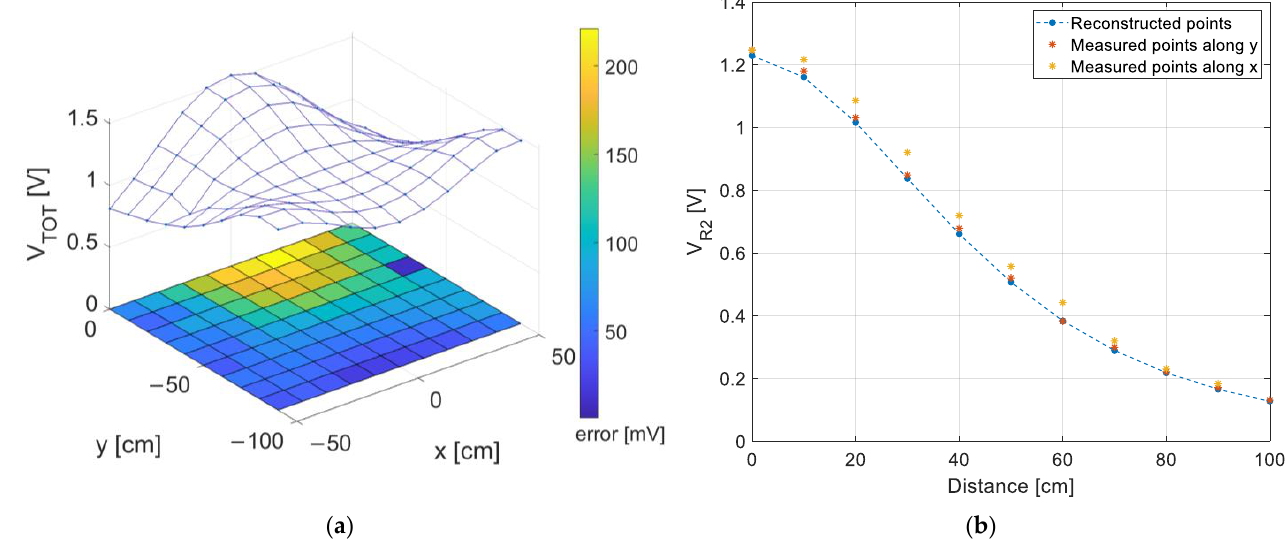
Figure 9. ( a ) The estimated RSSs distribution of the three LEDs as a 3D blue surface (i.e., the sum of the FFT-derived V Ri in each measurement point, V TOT ), on the ( x , y ) plane a heatmap reporting the absolute difference in mV between V TOT and the RSSs recovered using (2 ) and the ‘true’ d i . ( b ) Trend of the estimated V R2 versus the distance: in blue the trend recovered using (2 ) and the ‘true’ d i , the yellow and red marks are the FFT-extracted values moving respectively along x -axis and y -axis.